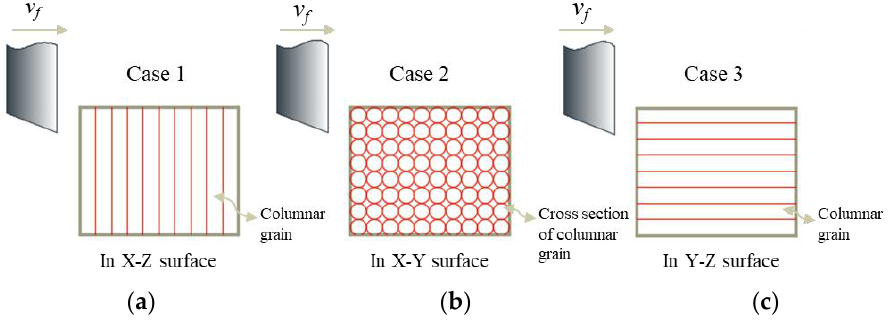
Figure 1. Illustration of relative direction between the cutting velocity and the columnar grain growth direction along build direction; ( a ) Case 1, ( b ) Case 2, and ( c ) Case 3.